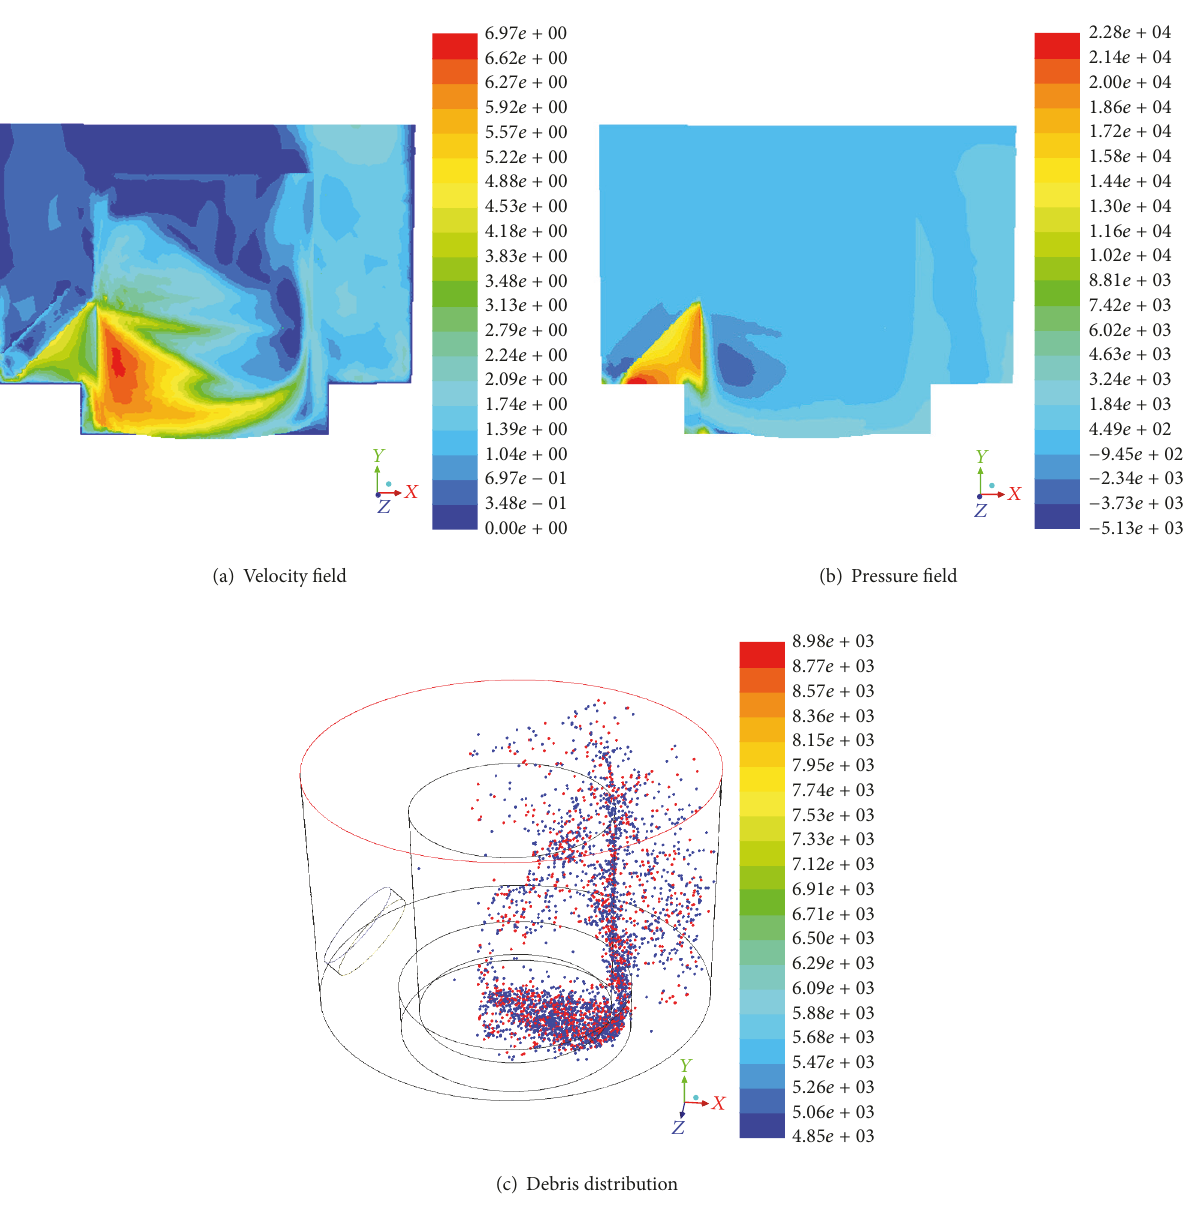
Figure 13: Schematics of gap flow field with flushing at 5 m/s and 0.5 mm deep